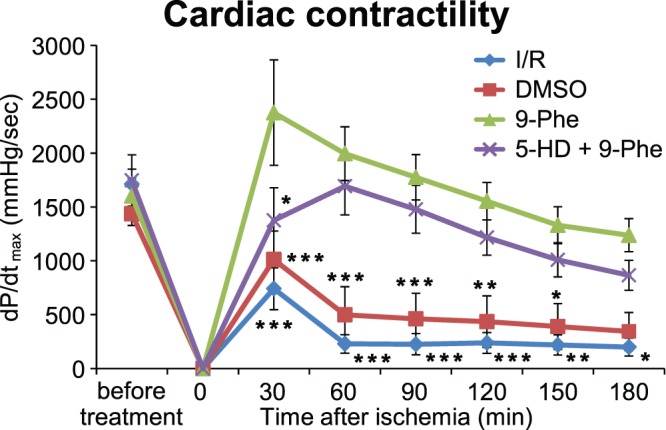
Analysis of heart contractility.Maximum value of the time derivative of LVP (dP/dtmax) was used as an indicator for cardiac contractility. In the I/R and DMSO groups, decrease in dP/dtmax is evident. In contrast, impaired contractility caused by I/R injury was significantly recovered by treatment with 9-Phe. Asterisks indicate a significant difference compared with the 9-Phe group as determined using Bonferroni post hoc tests.***p<0.001,**p<0.01,*p<0.05.